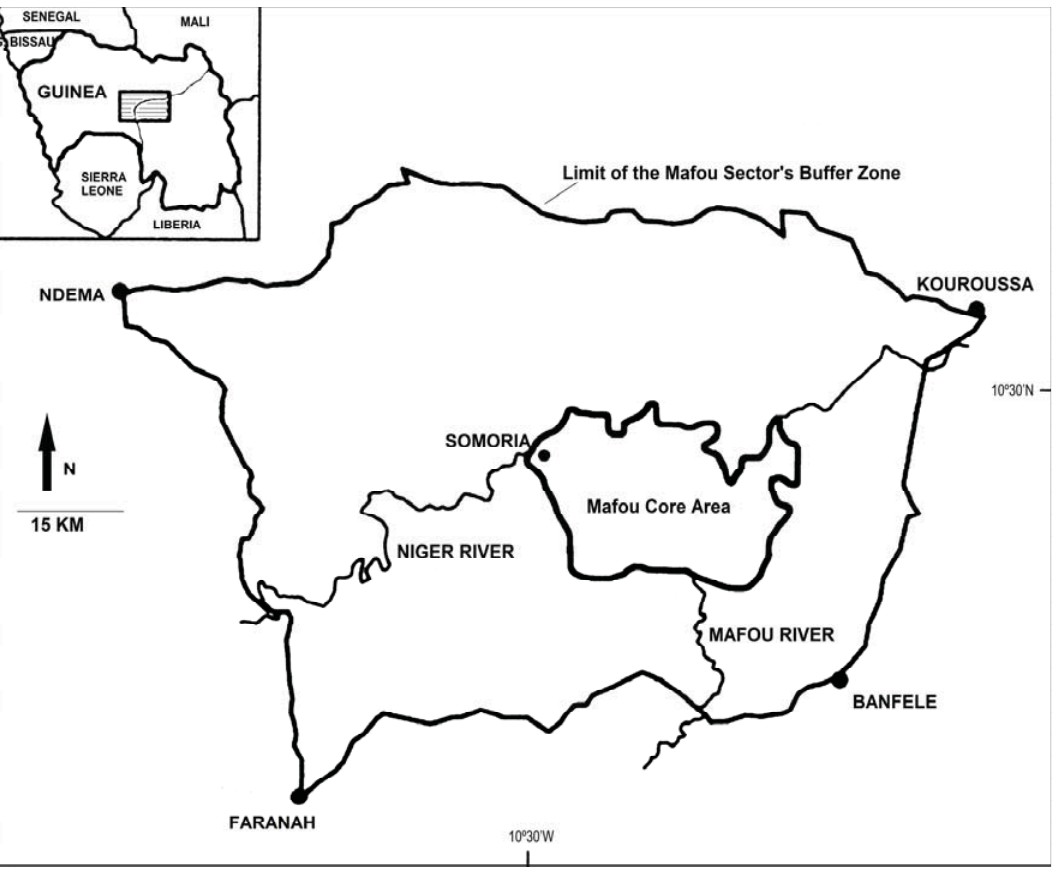
Figure 1. Map of the location of the Haut Niger National Park (HNNP) in Guinea, West Africa, highlighting the Mafou core area of the park and the relative location of the sanctuary in Somoria (adapted from